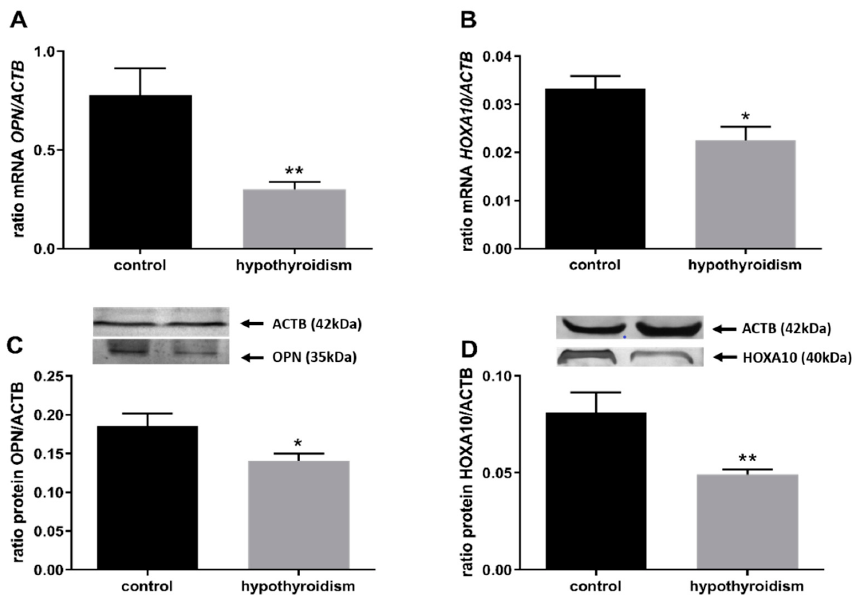
Figure 3. The effects of hypothyroidism on the mRNA and protein abundance of uterine-receptivity factors in the uterine tissue of rats: ( A , C ): OPN/OPN; ( B , D ): HOXA10/HOXA10. The values are pre- sented as arbitrary units and expressed as the mean ± SEM. Stars indicate significant differences (* p ≤ 0.05, ** p ≤ 0.01, *** p ≤ 0.001, **** p ≤ 0.0001), as determined by Student’s t -test.